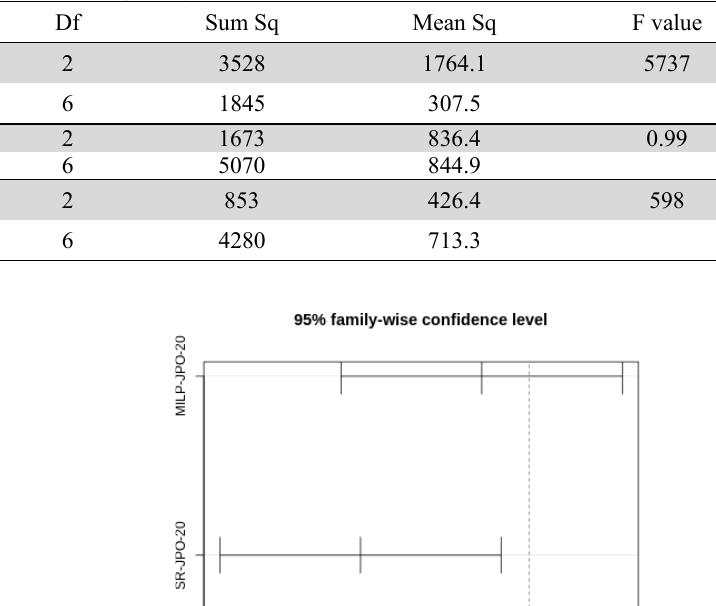
ANOVA of average RDI values depending on TF.